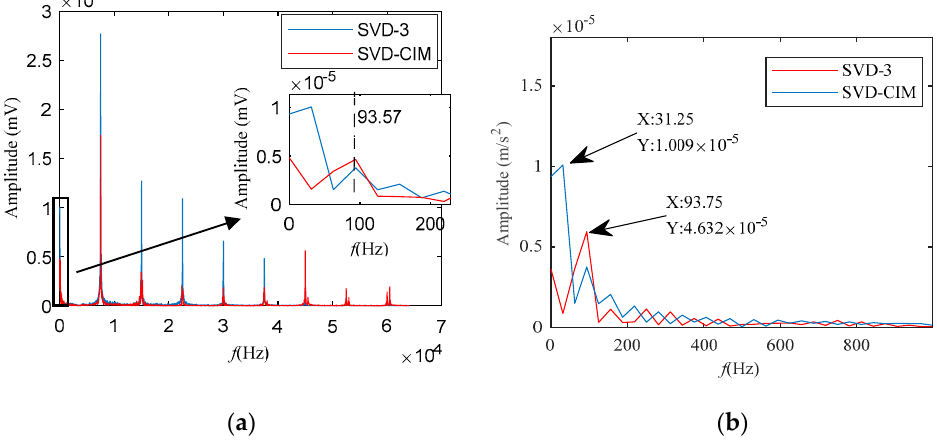
Figure 12. CCES of two methods. ( a ) CCES of signals. ( b ) Partially enlarged view of the